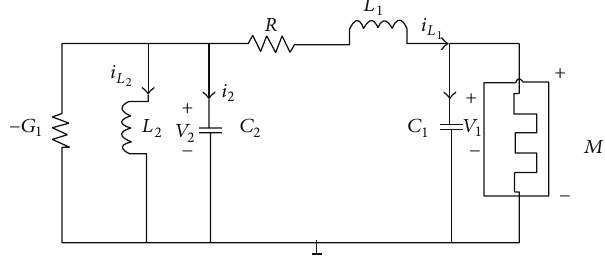
Figure 4: The schematic of Chua’s